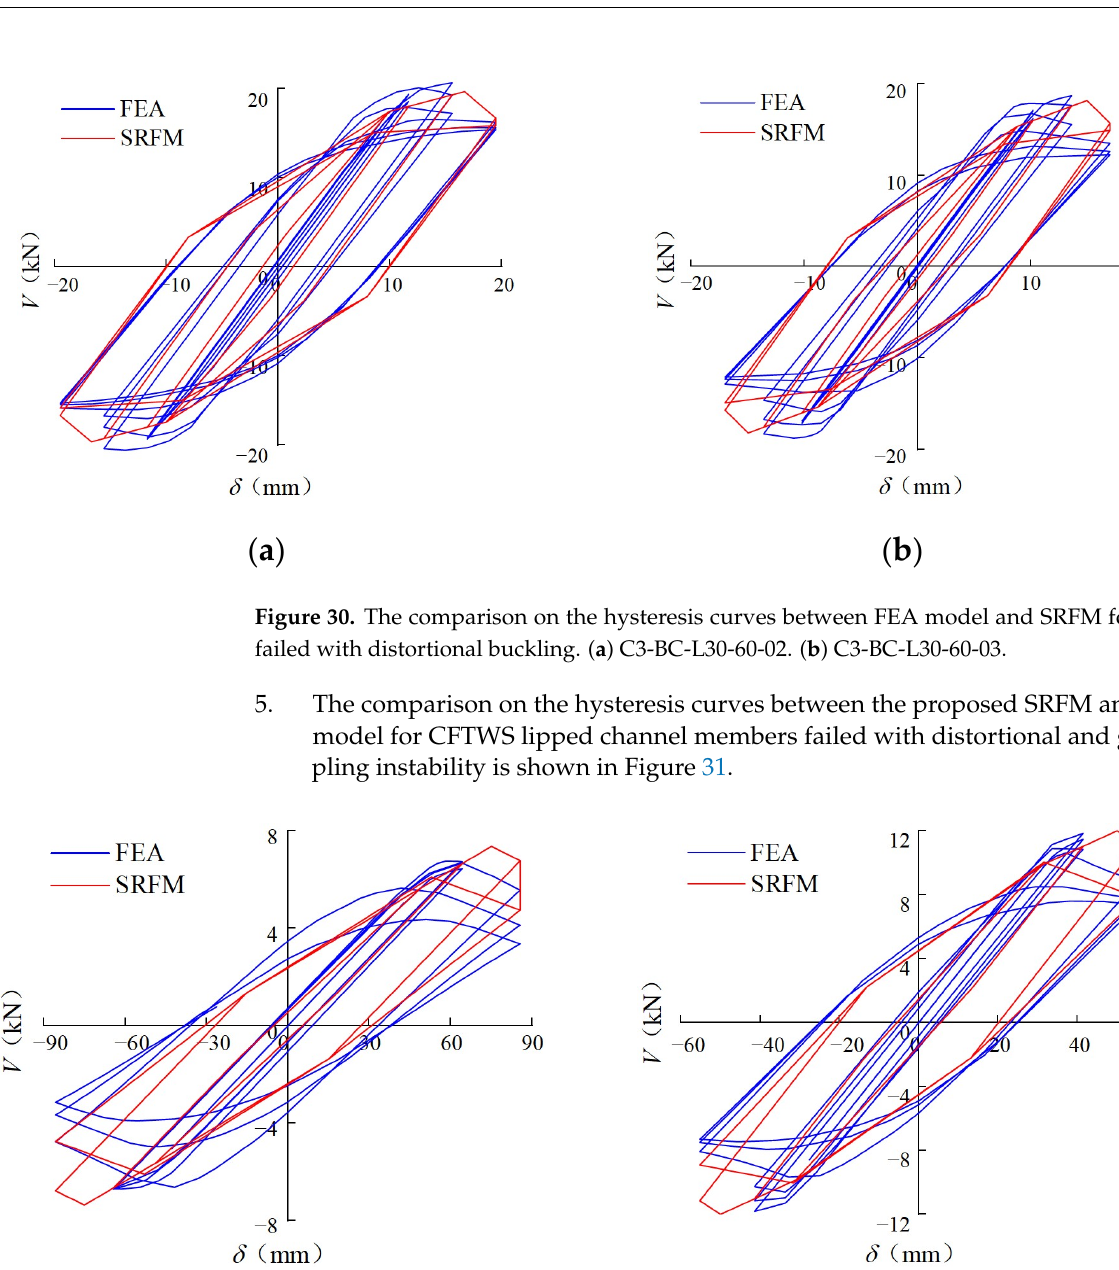
( b ) Figure 29. The comparison on the hysteresis curves between FEA model and SRFM for members failed with local buckling. ( a ) C4-BC-L15-70-02. ( b ) C4-BC-L30-70-02.